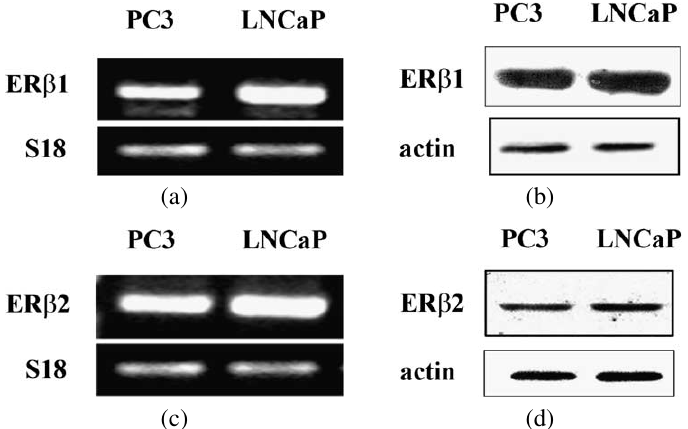
Fig. 1. ER β 1 and ER β 2 mRNA and protein expression in the human prostate cancer cell lines LNCaP and PC3. (a) With respect to ER β 1, the expected 207 bp product, corresponding to the 3 (cid:2) region, was amplified by RT-PCR analysis and (b) a band of approximately 64 kDa was detected by western blot assay using the PA1-313 antibody in LNCaP and PC3 cells. (c) The ER β 2 mRNA expression was demonstrated by RT-PCR in both cell lines and (d) its protein expression was confirmed by western blot analysis using the antibody generated against an specific carboxy-terminal